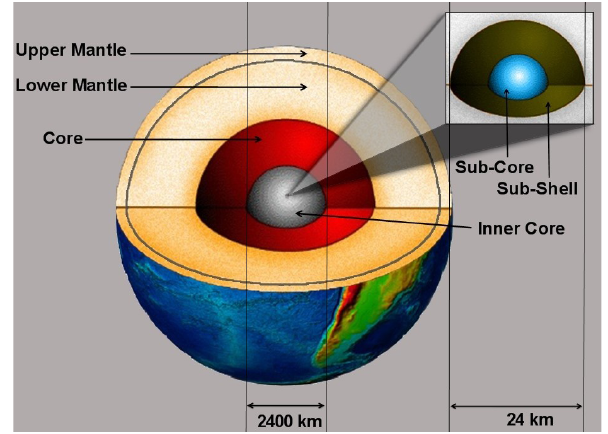
Figure 7. Schematic representation of the major parts of the Earth showing the georeactor at the center in expanded view. From Hern- don (2008). Figure 8. Fission product ratio of 3 He / 4 He, relative to air, from nu-